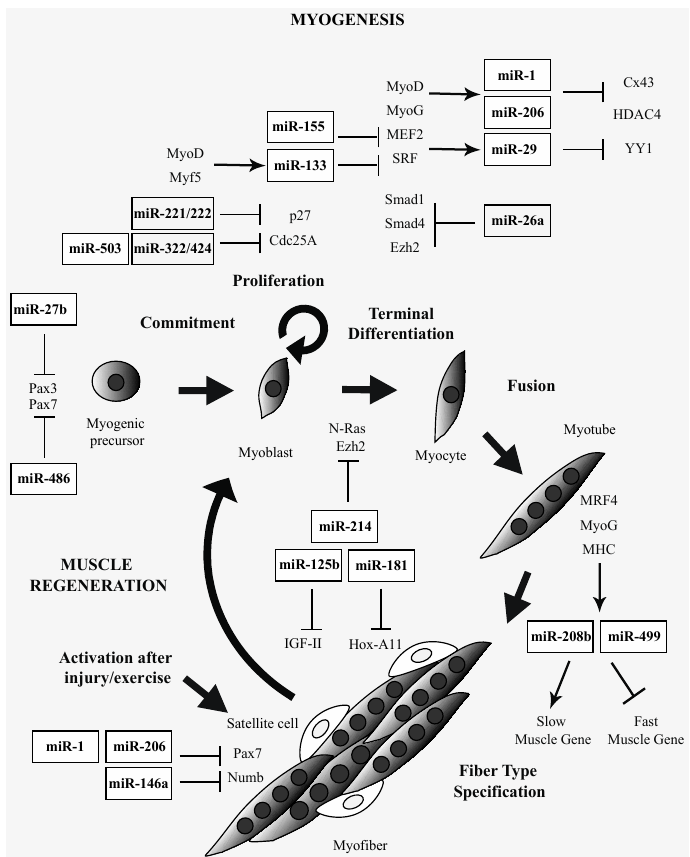
Figure 1. Overview of muscle-specific and ubiquitously expressed miRNAs that contribute to myogenesis and muscle regeneration processes and their regulatory activity on the muscular specific targets/chromatin modifying enzymes/cell cycle regulators (for details see the text). The main regulatory factors that exert a fundamental role during each step of normal muscle development are also reported as well as their eventual regulatory activity on the described